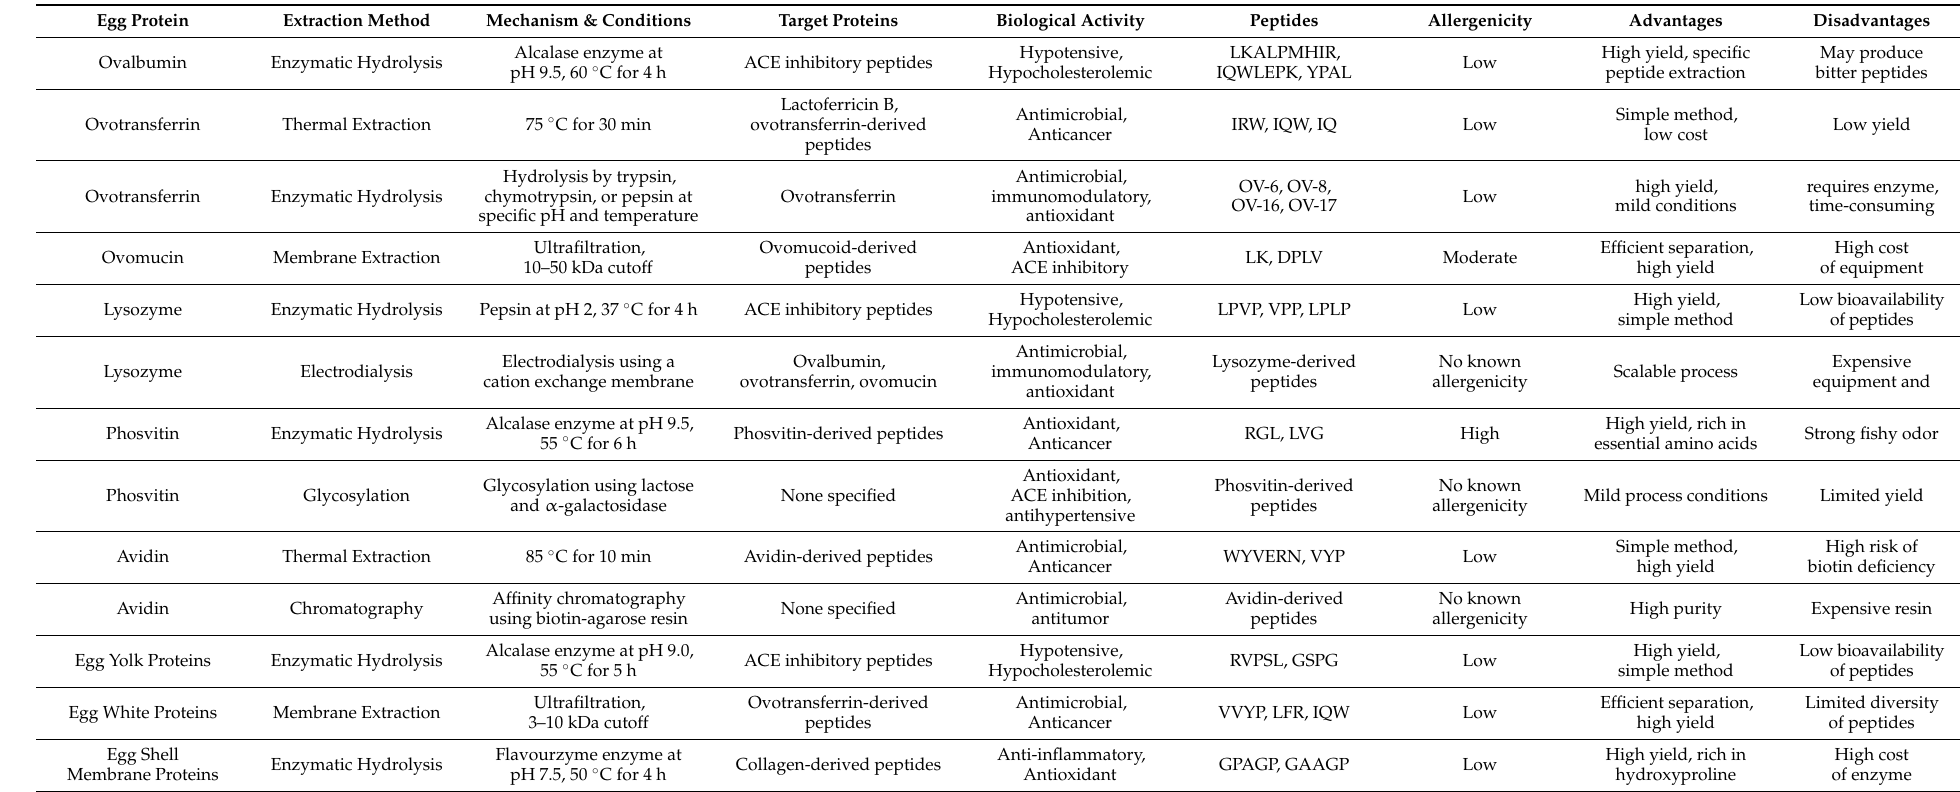
Table 4. Some examples of peptides with biological activity are extracted from egg